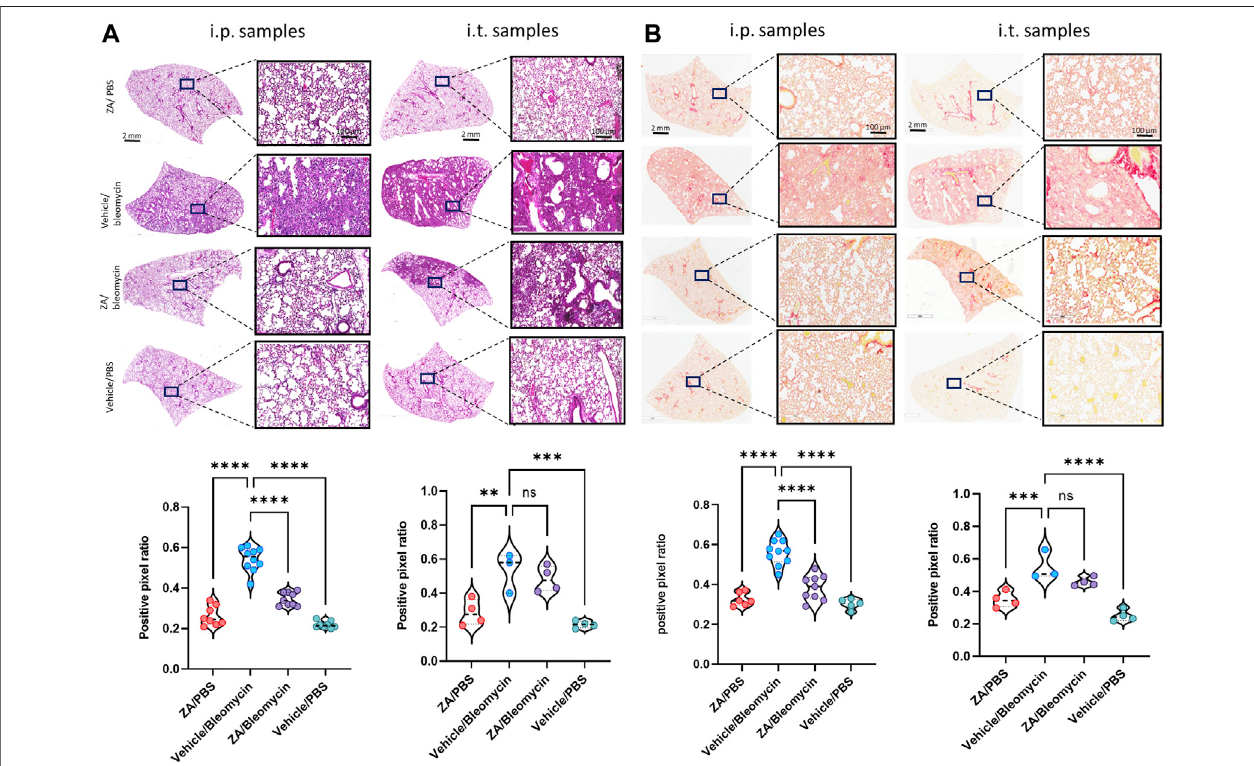
FIGURE4| Murinelungstainingdisplaysreducedlevelsof fi brotic-relatedlungdamagefollowingZA(i.p.)treatmentcomparedtobleomycin/vehiclesamples (A) ZA (i.p.) signi fi cantly decreased lung damage in bleomycin-treated mice (H&E) and (B) collagen deposition (picrosirius red) in both macroscopic and microscopic structures comparedtovehicle/bleomycinlungsandwascon fi rmedbypositivepixelanalysisofwhole-lungscannedimages(scalebarofmicroscopicimage=100 μ m;scalebarof whole lung scan = 2 mm). Statistical analyses were conducted using a one-way ANOVA followed by a Dunnett ’ s post-hoc test ( **p < 0.01 ; ***p < 0.005; * p <